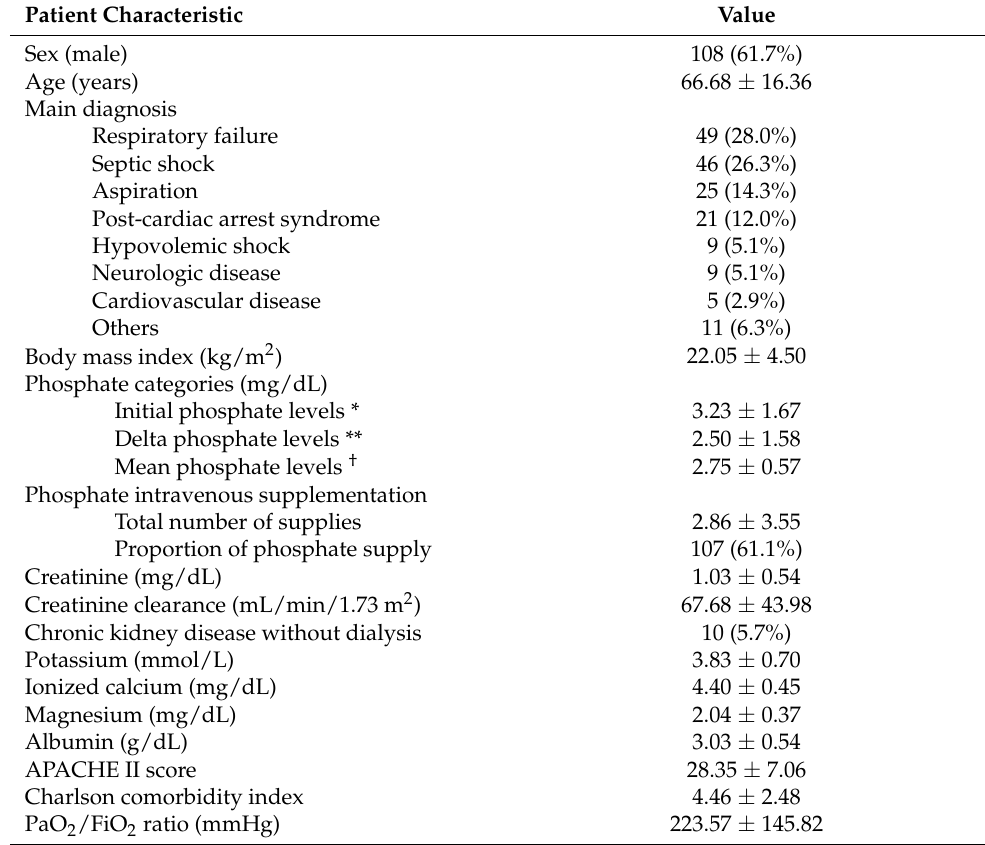
Table 1. Baseline patient medical and demographic characteristics ( n = 175).